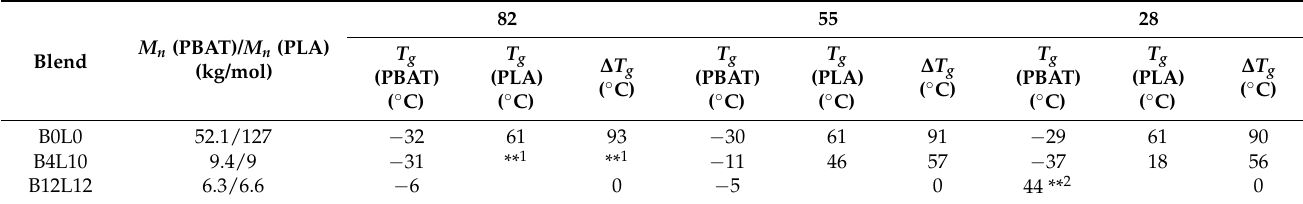
Table 3. Glass transition temperatures of PBAT/PLA blends with different molecular weights and compositions.